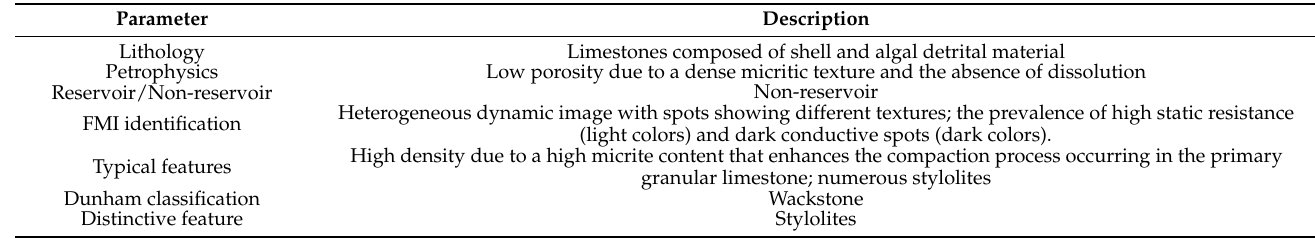
Table 3. Description of main reservoir parameters for RT2.